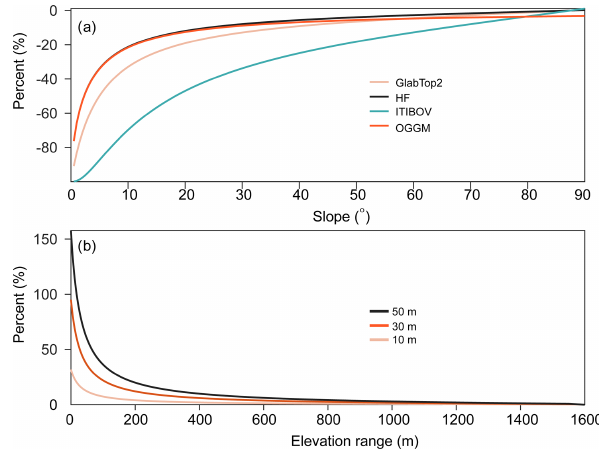
Figure 14. Sensitivity test of slope and elevation on ice-thickness inversion models. (a) Percentage difference of modeled ice thick- ness from GlabTop2, HF, ITIBOV, and OGGM when there is + 5 ◦ slope error. (b) Percentage difference of modeled ice thickness from GlabTop2 when the elevation range error is + 10, + 30, and + 50m for different elevation